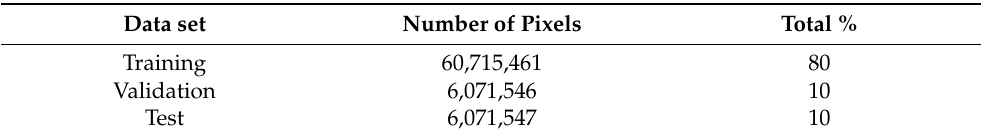
Table 5. Training, validation and test data sets.